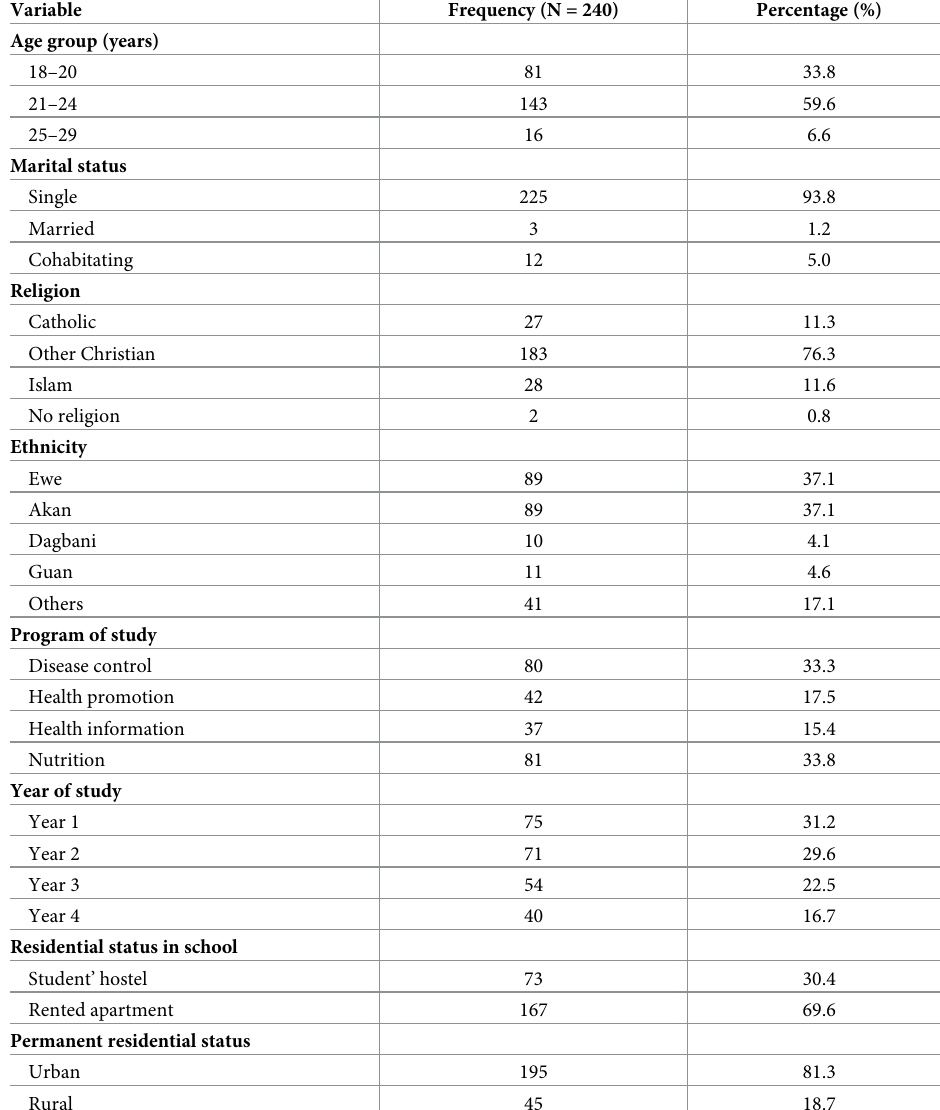
Table 1. Demographic characteristics of